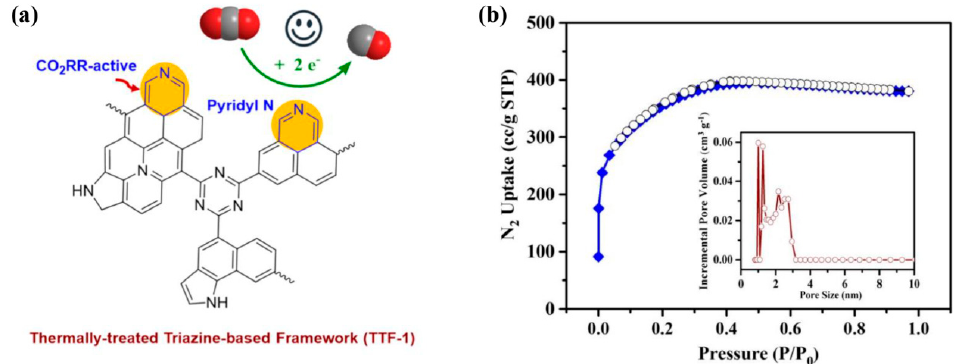
Figure 2. ( a ) The structure of triazine linking framework TTF-1. ( b ) N 2 − sorption isotherms on TTF-1 were recorded at 77 K and the corresponding pore size distribution [48]. Reprinted with permission from Ref. [48]. Copyright 2018 Copyright, American Chemical Society. (Washington, DC, USA). The size of the pore can affect the charge density of the polymer and the confinement of the pore to the active site. Tang et al. [49] synthesized a series of porous polymers, POP- Py (n) (n means the quantity of benzene rings), through the reaction of benzyl bromide and pyridine. POP-Py (n) with pore sizes from micropore to mesopore were obtained by changing the amount of benzene rings (Figure 3a). The highly efficient electrocatalyst was obtained by encapsulating cobalt meso-tetra(4-carboxyphenyl)porphyrin (CoTCPP) (Fig- ure 3b) into POP-Py (n) by the ion exchange method, with single-molecule dispersion. POP-Py (0)/CoTCPP showed the highest FE co of 83% at − 0.6 V vs. RHE, which is twice as high as the activity of the pure CoTCPP molecular electrocatalytic conversion of CO 2 to CO (Figure 3c). The high activity is caused by the monomolecular dispersion of CoTCPP in the pores of POP-Py (0), which promotes the electrochemical accessibility of active sites. Moreover, the positively charged substituted pyridine ring in POP-Py can stabilize the key reaction intermediate *COOH to accelerate the conversion of CO 2 . When a neutral benzyl ring is inserted between two pyridine rings, the positive charge on the pyridine ring will be delocalized through the conjugation effect. Hence, the interaction between POP-Py and key reaction intermediate *COOH becomes weaker. In addition, at a high overpotential, the current attenuation of POPy-Py(2) indicated the aggregation of CoTCPP (Figure 3d).